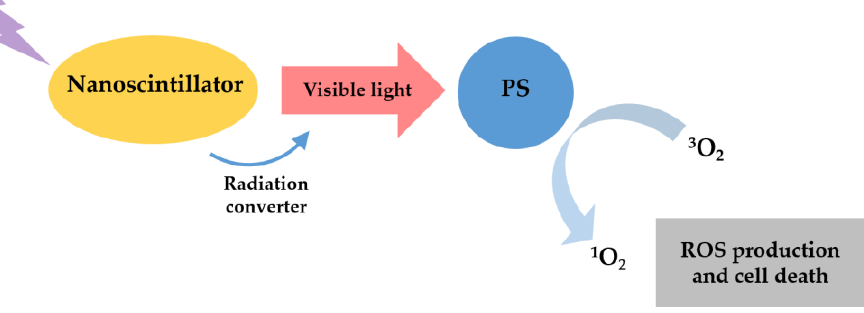
Figure 5. Schematic illustration of the classic X-PDT. X-rays excite a nanoscintillator to generate X-ray luminescence, which in turn activates a PS to produce cytotoxic ROS.